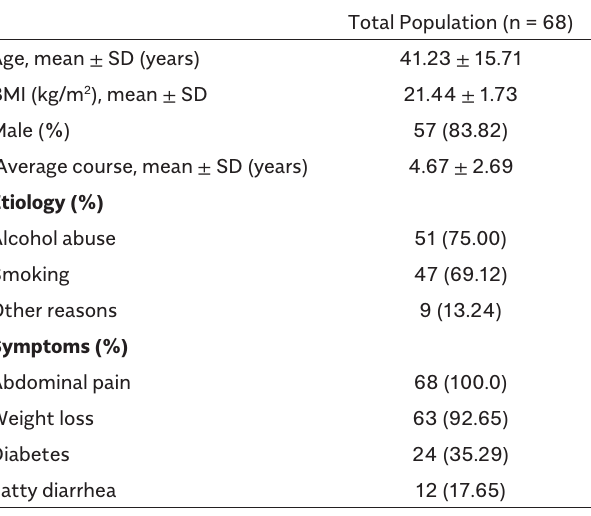
Table 1. Clinical Characteristics of Patients with PDS